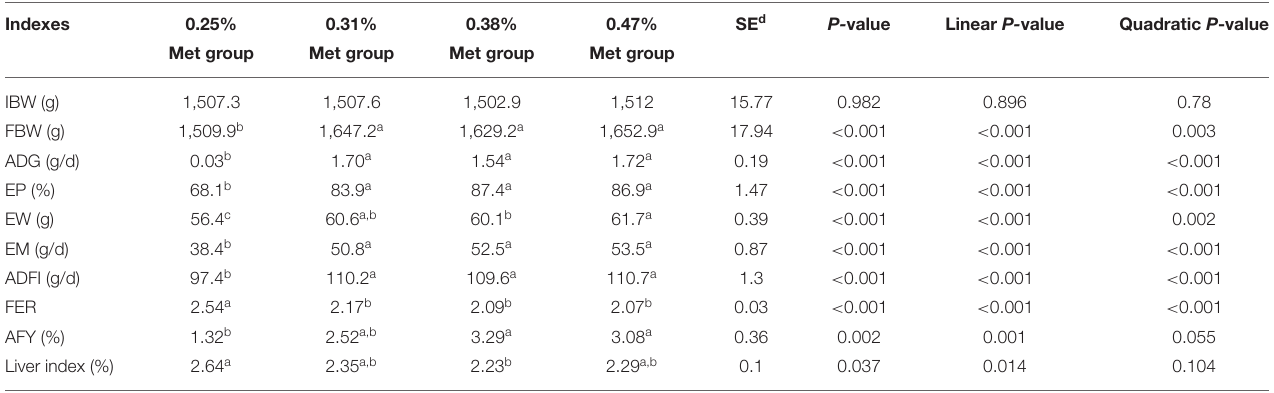
TABLE 1 | Effects of different dietary Met supplementation in low protein diets on the growth and laying performance of laying hens that are 38–50 weeks. Indexes Linear P- value Quadratic P -value Met group Met group